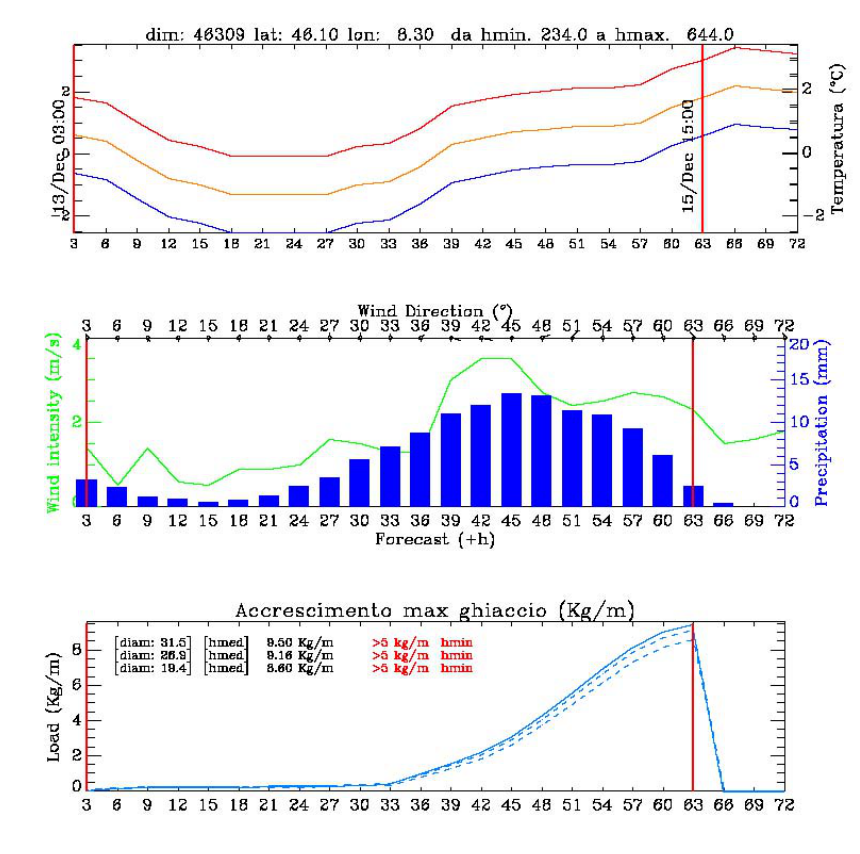
Fig. 4. Time diagramme of a major wet snow event referred to: (Ossola Valley – Piedmont – Italy; 13–15 December 2008).